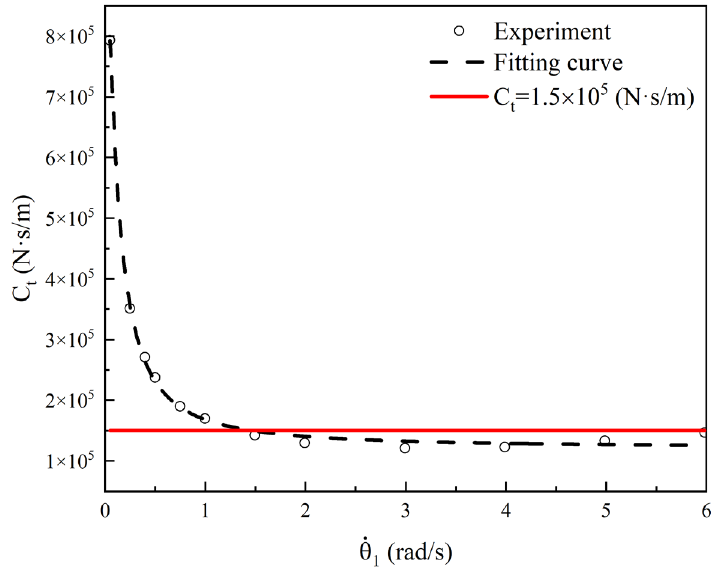
Figure 10. Damping coefficient vs. crank angular velocity for the driving mechanism.